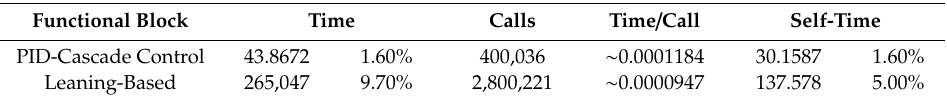
Table 2. Complexity